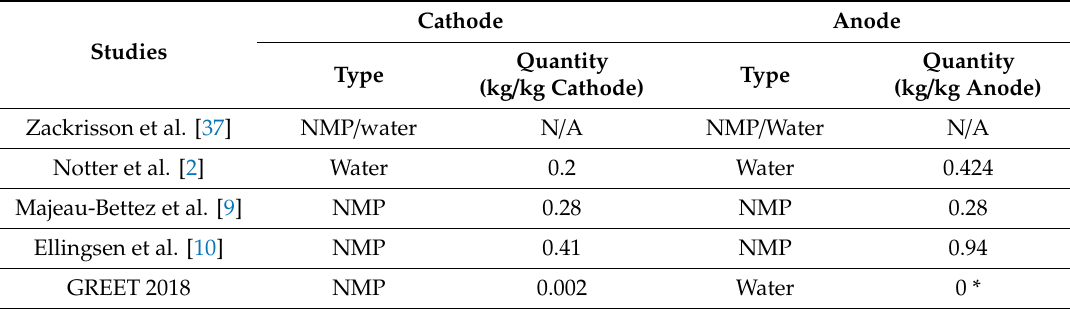
Table 2. Solvent use for slurry preparation in existing LCA